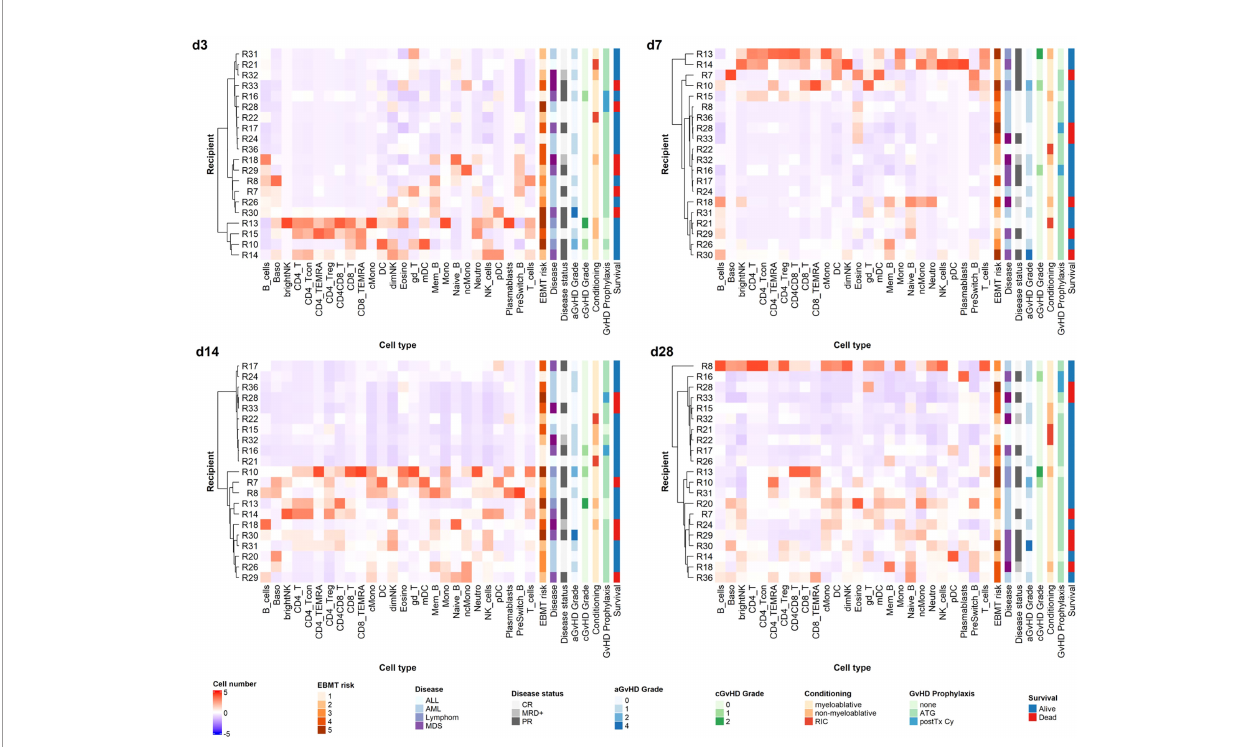
FIGURE 6 | Unsupervised hierarchical clustering of recipients according to cell counts on early time points. Unsupervised hierarchical clustering (ward.D) of Z-transformed cell count values for different time points reveals distinct reconstitution groups on days +14 and +28 post alloHSCT. T_cells, T cells; CD8_T, CD8 T cytotoxic cells; CD8_TEMRA, CD8 terminally differentiated memory T cells; CD4_T, CD4 T helper cells; CD4_Treg, Regulatory CD4 T cells; CD4_Tcon, Conventional CD4 T cells; CD4_TEMRA, CD4 terminally differentiated memory T cells; CD4CD8_T, CD4CD8 double positive T cells; gd_T, gamma-delta T cells; B_cells, B cells; Naive_B, Naive B cells; NonSwitch_B, Non-switched memory B cells; Mem_B, Memory B cells; Plasmablasts, Plasmablasts; NK_cells, NK cells; brightNK, CD56 bright NK cells; dimNK, CD56 dim NK cells; Mono, Monocytes; cMono, Classical monocytes; ncMono, Non-classical monocytes; DC, Dendritic cells; pDC, Plasmacytoid dendritic cells; mDC, Myeloid dendritic cells; Neutro, Neutrophils; Eosino, Eosinophils; Baso, Basophils; aGvHD, acute GvHD; cGvHD, chronic GvHD; CR, complete response; MRD+, minimal residual disease positive; PR, partial response. For GvHD prophylaxis; “ none ” depicts patients